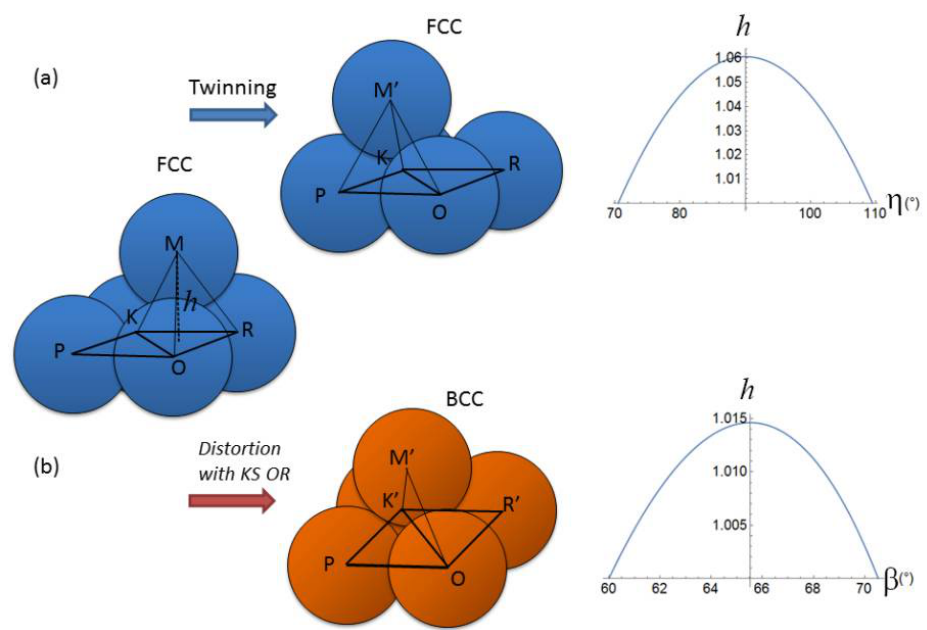
Figure 22. Hard-sphere model of ( a ) fcc-fcc deformation twinning and ( b ) fcc-bcc martensitic transformation. The distance h is the distance between the planes, initially POK = (111) γ . This distance changes during the transformation process. Both fcc-fcc twinning and fcc-bcc martensitic transformations are modelled as functions of a unique angle of distortion, noted η and β, respectively. In both transformations, the dense plane POK and the dense direction PO remain untilted. Reprinted from [123] with permission from Elsevier.